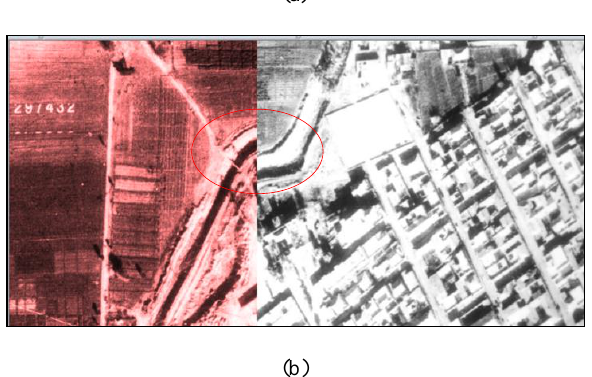
Figure 10. Results after assembling the orthophotos.